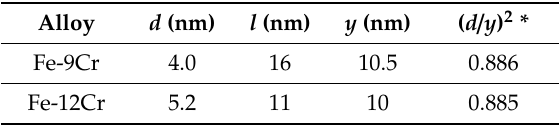
Table 3. Mean values of size d , spacing l , stand-o ff distance y , and ( d / y ) 2 derived from the TEM analyses performed for the 0.6 dpa irradiations.